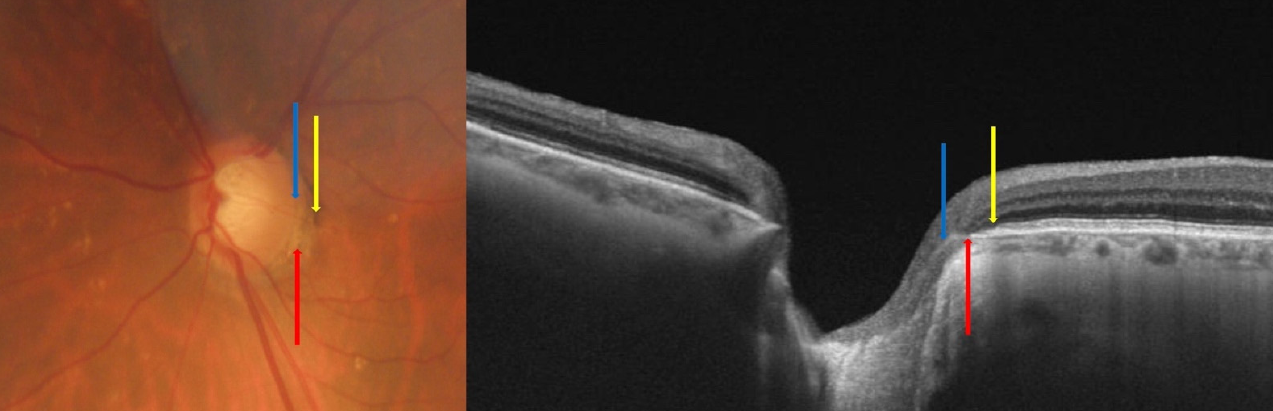
Table 1. ONH characteristics in myopic subjects. α -PPA Irregular RPE with the presence of BM β -PPA Absence of the RPE and the presence of BM Absence of both the RPE and BM with the presence of only the γ -PPA peripapillary RNFL Table 1. Cont. Absence of microvessels larger than 50 microns usually within δ -PPA the γ -PPA zone Absence of microvessels larger than 50 microns usually δ -PPA within the γ -PPA zone Angle between two lines: the first line connecting the inner edges of BM on each side of the ONH on the cross-sectional OCT image Angle between two lines: the first line connecting the inner ONH tilt angle edges of BM on each side of the ONH on the cross-sectional and a second line connecting the two points of the clinical disc ONH tilt angle OCT image and a second line connecting the two points of the margin along the OCT cross-sectional scan clinical disc margin along the OCT cross-sectional scan Angle between the vertical meridian of the line connecting the Angle between the vertical meridian of the line connecting the ONH torsion angle center of the BMO and fovea and the longest diameter of the ONH torsion angle center of the BMO and fovea and the longest diameter of the BMO-delineated ONH margin defined by OCT BMO-delineated ONH margin defined by OCT Triangular hyporeflective shape with the apex heading into the ONH pits Triangular hyporeflective shape with the apex heading into the ONH pits interior of the ONH observed in enface images interior of the ONH observed in enface images Hyporeflective triangular thickening of the choroid with the base Hyporeflective triangular thickening of the choroid with the PICC at the optic disc border excluding peripapillary large choroidal PICC base at the optic disc border excluding peripapillary large vessels choroidal vessels Cystoid hyporeflective spaces in the peripapillary region around Cystoid hyporeflective spaces in the peripapillary region PPRS PPRS retinal vessels around retinal vessels Peripapillary staphy- Arched posterior sclera with less curvature in adjacent regions, Arched posterior sclera with less curvature in adjacent regions, Peripapillary staphyloma loma the choroid at the edge of the staphyloma is thinned the choroid at the edge of the staphyloma is thinned